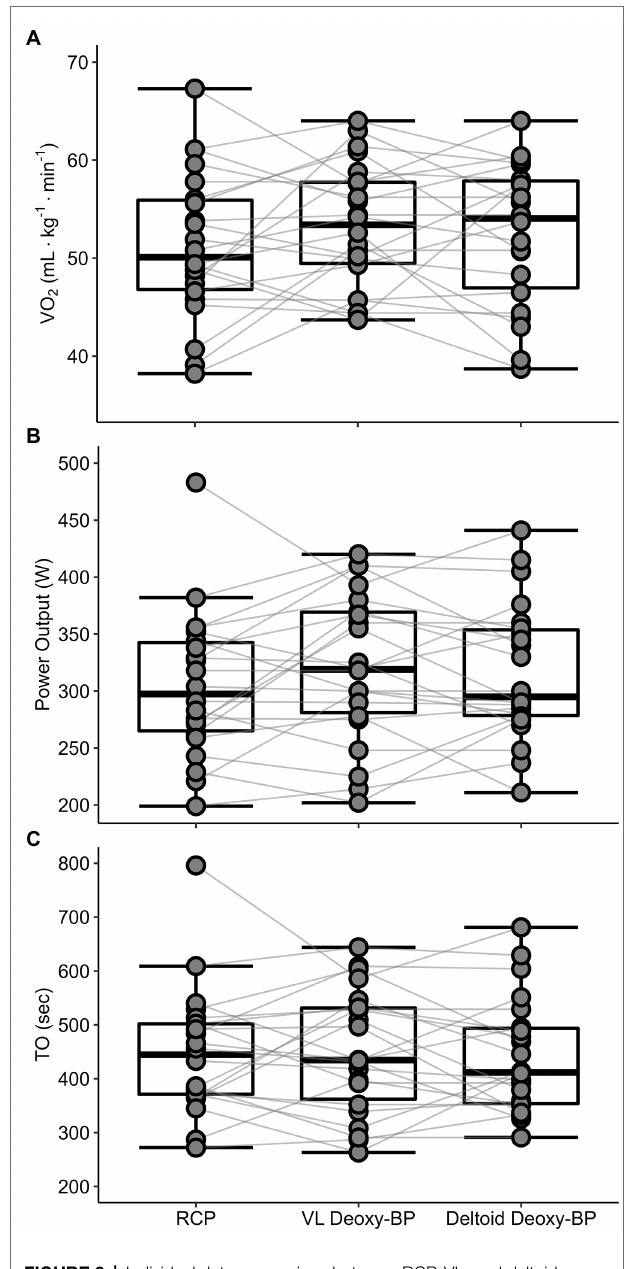
FIGURE 3 | Individual data comparison between RCP, VL, and deltoid Deoxy-BP for V ̇ O 2 (ml·kg − 1 ·min − 1 ; panel A ), power output (PO in W; panel B ), and time of occurrence (TO in s; panel C